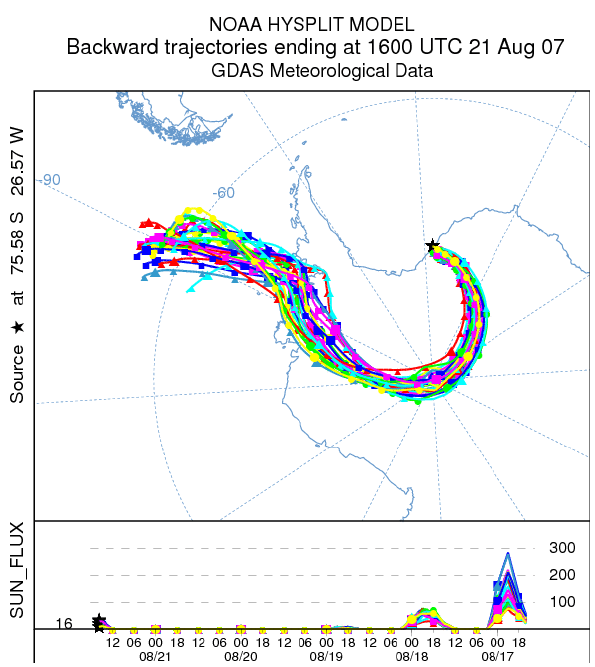
Fig. 10. 5-day HYSPLIT Ensemble back trajectory from Halley. In- cluded is a measure of “Downward Solar Radiation Flux (Wm − 2 )” to indicate when the air parcel last experienced light.